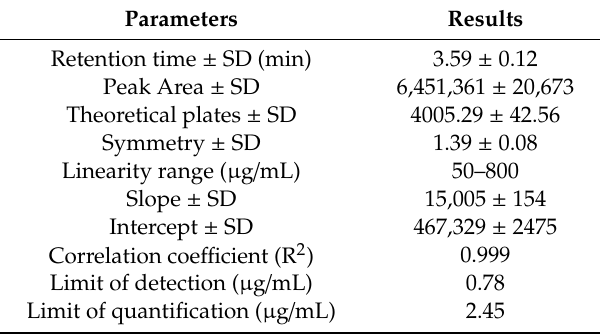
Table 1. System suitability and validation parameters for sinigrin (400